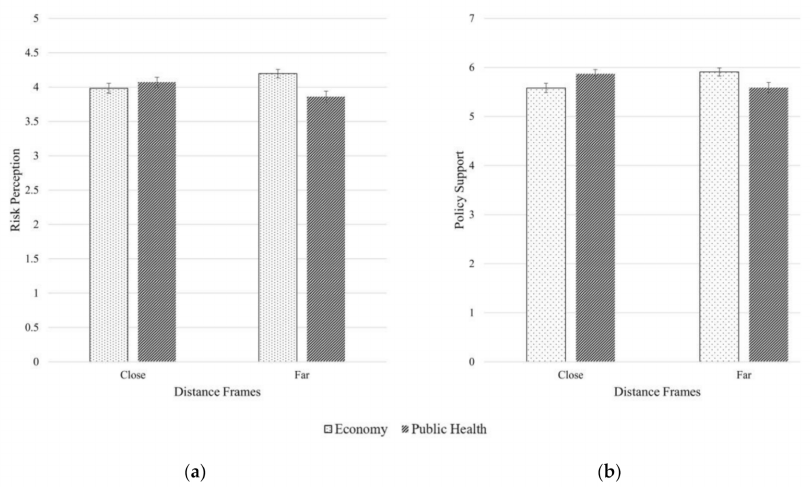
Figure 2. Issue framing and distance framing interact to influence risk perception and policy support. ( a ) Perceived risk of climate change reported by participants assigned to four experimental conditions; ( b ) Support for climate change mitigation policies reported by participants assigned to four experimental